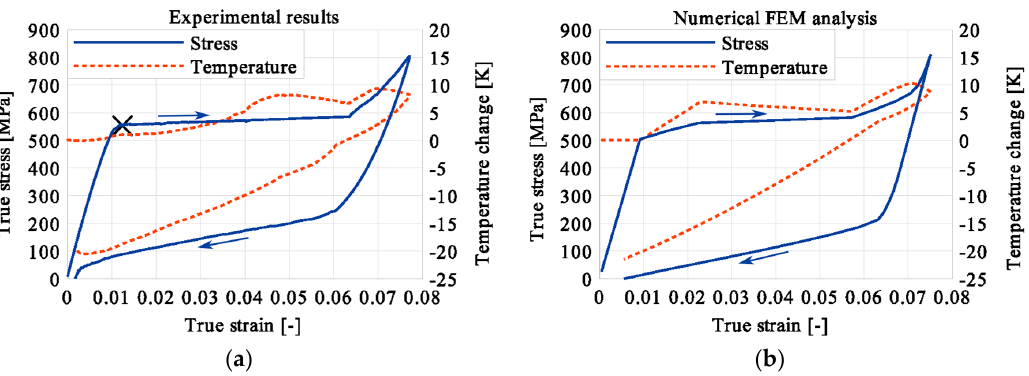
Figure 5. Stress and temperature variations vs. strain for the loading program (1): 3-min loading interruption at the beginning of the localized martensitic transformation (LMT): ( a ) experimental; ( b ) numerical results.